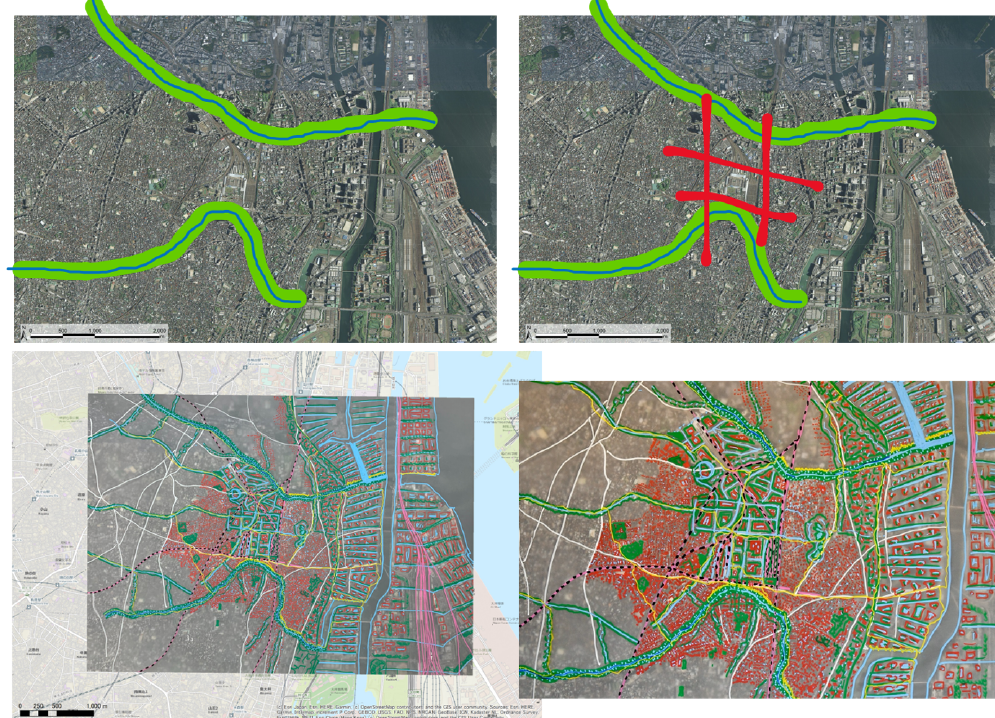
Figure 13. Urban design in consecutive